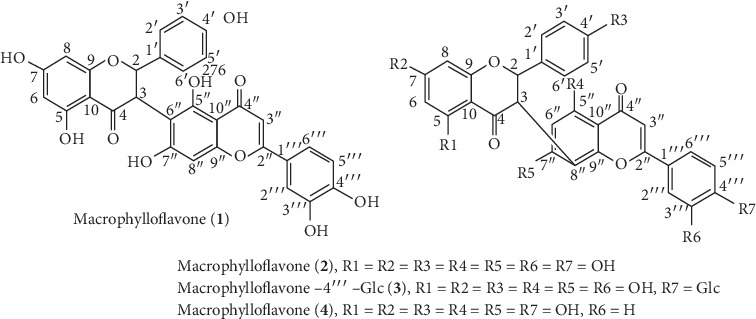
Macrophylloflavone (1); morelloflavone (2) [37–42]; morelloflavone-4‴-O-β-D- glucoside (3) [30]; and volkensiflavone (4) [43].